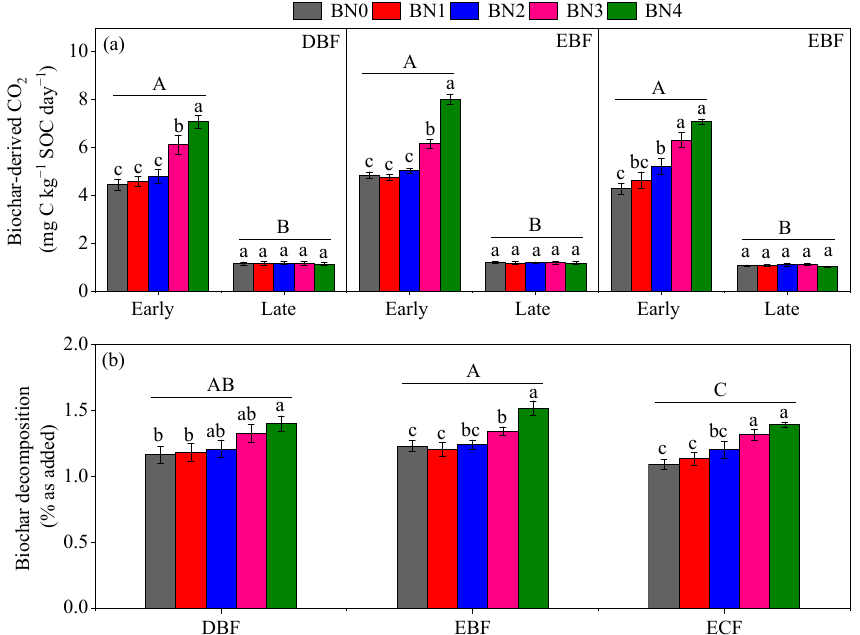
Figure 1. Effects of N addition on biochar decomposition rate during the early and late periods ( a ) and the cumulative decomposition of biochar after a 365-day incubation ( b ) in three forests. Bars represent standard errors of the mean (n = 4). Different capital letters in figure ( a ) represent significant differences between periods. Different capital letters in figure ( b ) indicate significant differences between forests. Different lowercase letters above bars represent significant differences among treatments within periods. Significance levels are set at p <